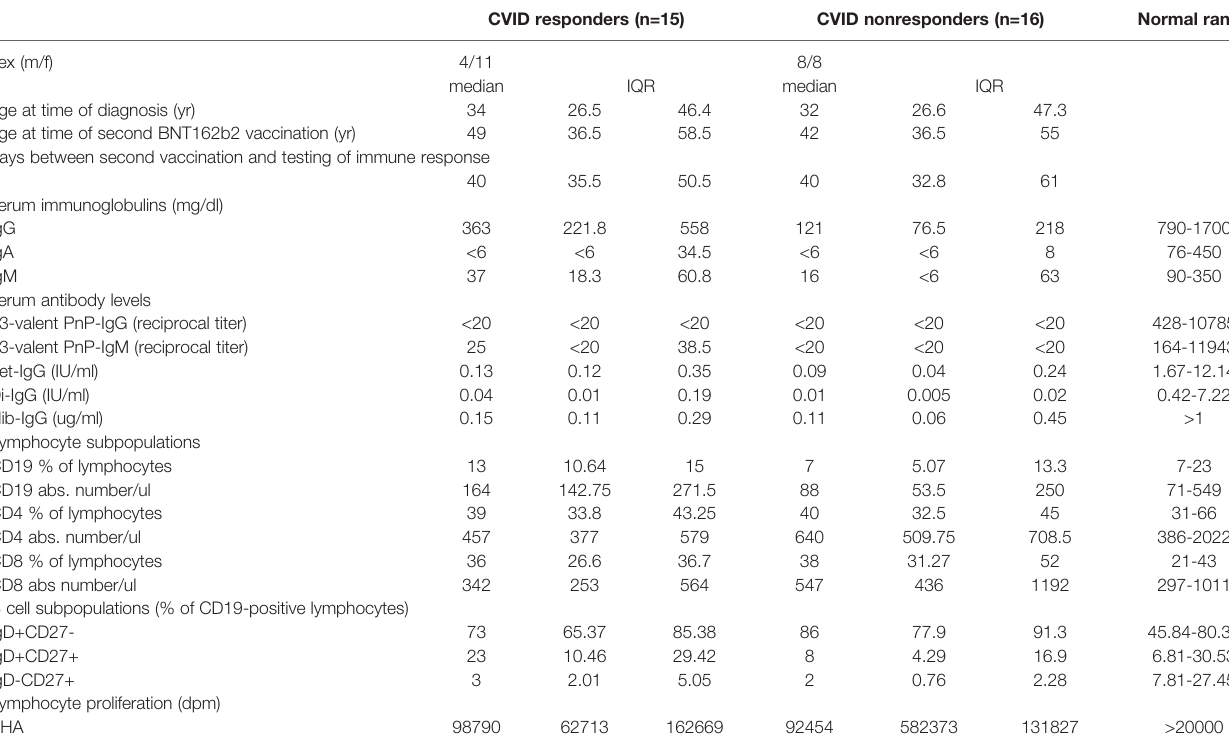
TABLE 1 | Characterization of CVID patients with or without IgG-antibody production following second BNT162b2 mRNA COVID-19 vaccination. CVID responders (n=15) CVID nonresponders (n=16) Normal